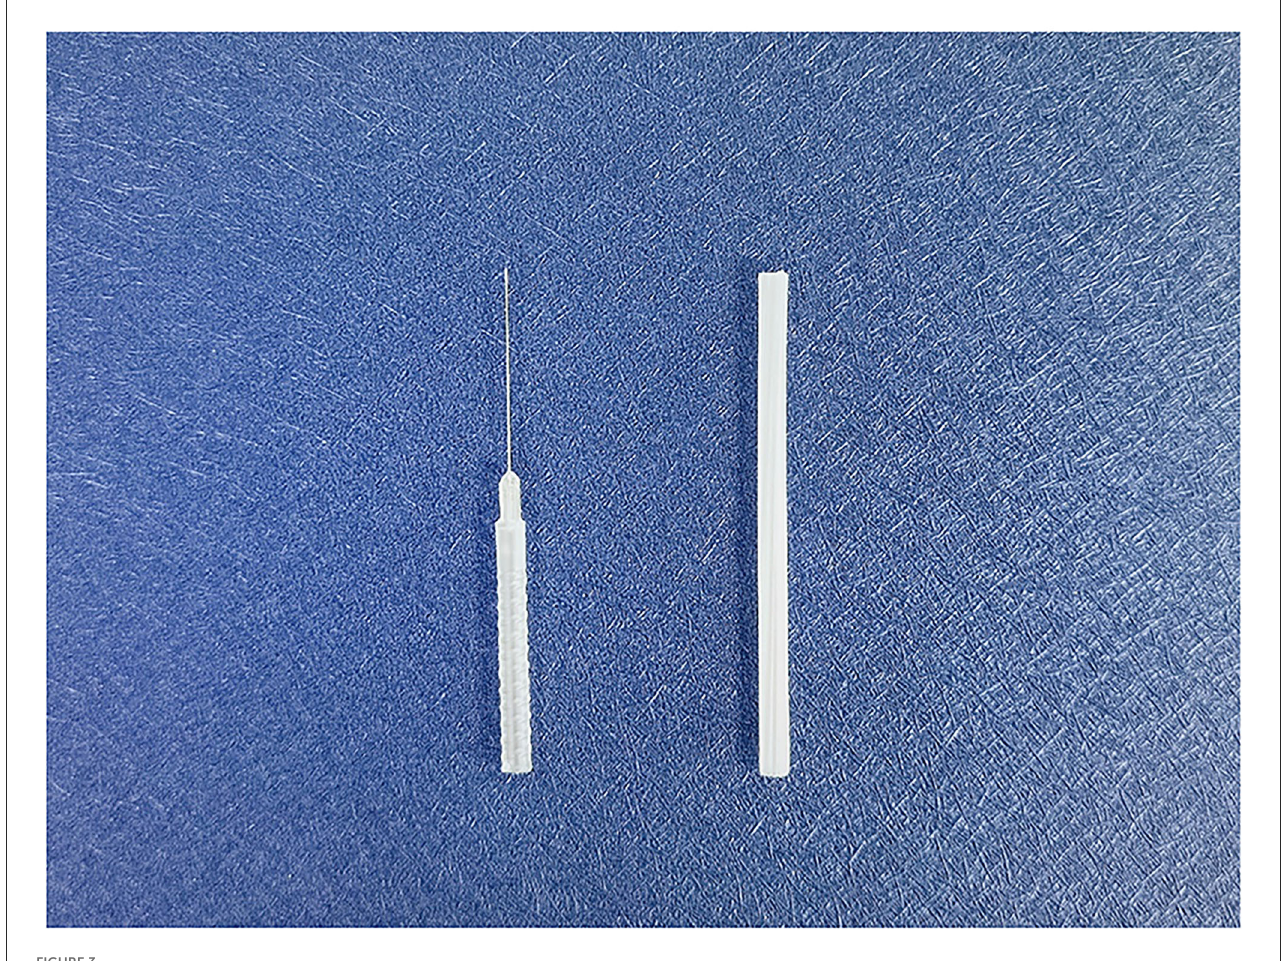
FIGURE3 Qihuang needle (left) and the protective cap (right)